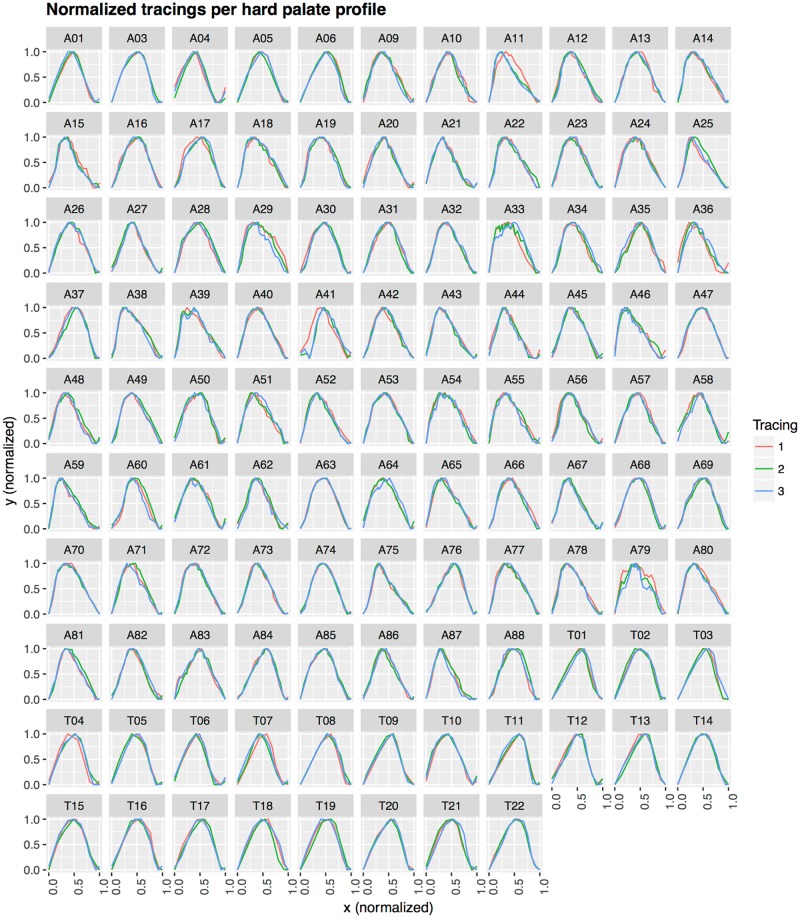
Normalized tracings per hard palate profile.This uses the same conventions as Fig 10 except that now the x and y coordinates are normalized to the interval [0, 1] (i.e., translated, rated and scaled). Here, it is clearer that the three replication tracings are quite consistent but there are also slight differences between them.